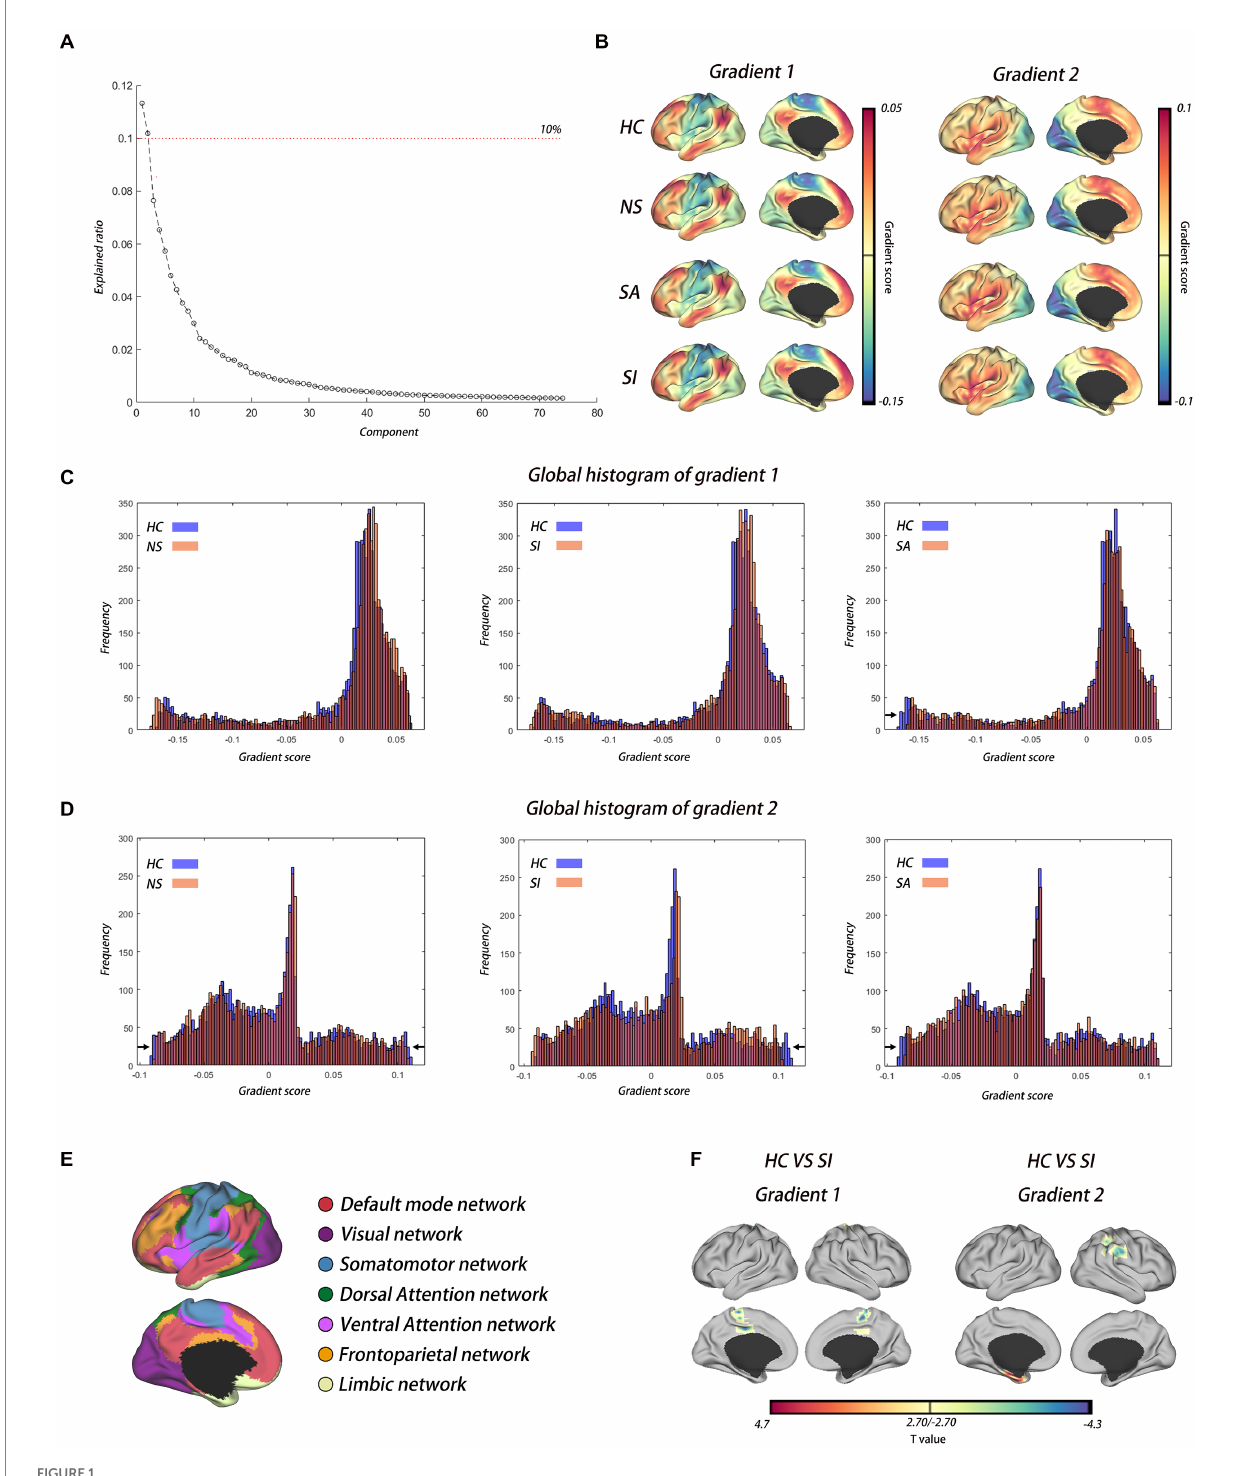
FIGURE 1 The cortical hierarchy dysfunction in MDD with diverse suicide risks. (A) Variance explained by gradient; the dotted curve shows gradients that explained more than 10% of connectome variance in the dataset. (B) The first and second functional gradients’ spatial pattern in HC and MDD with diverse suicide risks. (C,D) Global histograms showed the depolarization phenomenon in MDD patients with diverse suicide risks compared with HC in gradient 1 and gradient 2, respectively. (E) Seven networks template estimated by Yeo. (F) Voxel-wise statistical comparisons between HC and MDD patients with SI in gradient 1 and gradient 2, respectively (GRF corrected, voxel level of p < 0.01, cluster level of p < 0.05). HC, health controls; NS, not suicidal group; SI, suicide ideation group; SA, suicide attempt